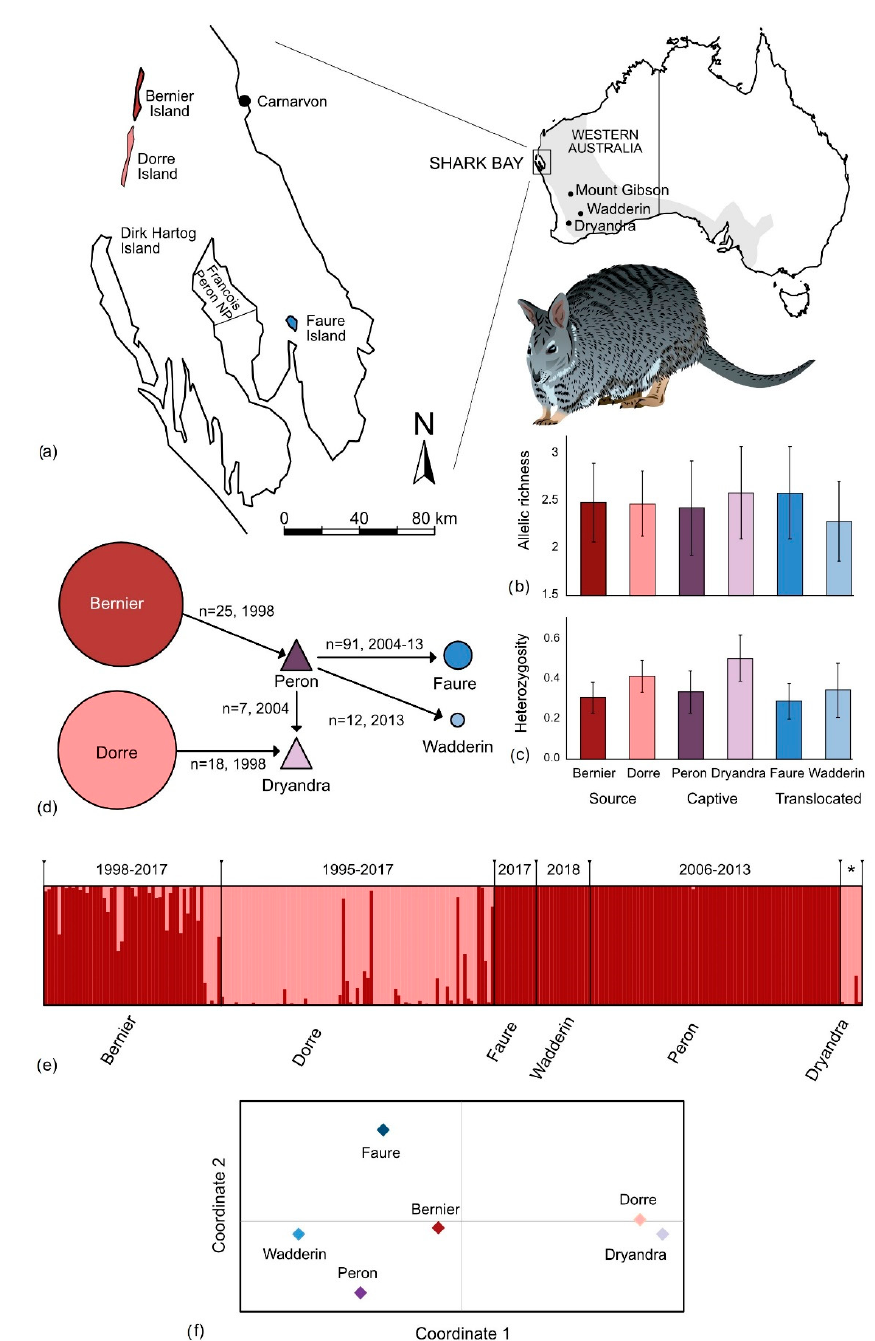
Figure 1. ( a ) Distribution of L. fasciatus in Western Australia (inset shows the approximate historical distribution); ( b , c ) measures of genetic diversity based on seven microsatellite markers; ( d ) translocation history (failed translocations not shown). Two recent translocations to Mt. Gibson and Dirk Hartog Island are underway; ( e ) STRUCTURE analysis of the two remnant wild populations (Bernier and Dorre Islands), two translocated populations (Faure Island and Wadderin), and two historic captive breeding populations (Peron Captive Breeding Centre (CBC) and Dryandra). Sampling periods are indicated at top of plot; * sampling period for Dryandra is 1999–2002; ( f ) population-level principal coordinates analysis based on genetic distance. The first two axes explain 91.6 of the variation. The L. fasciatus image was designed by Creazilla